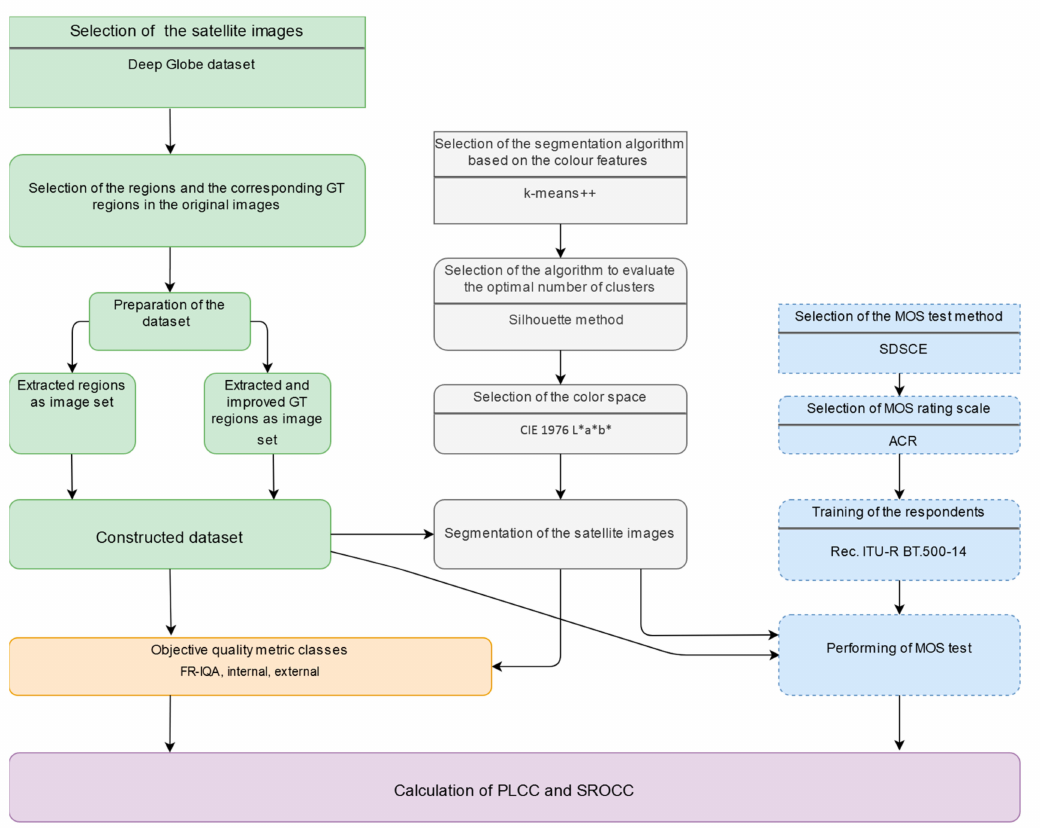
Figure 5. Framework illustrating the workflow for obtaining final results (di ff erent colours present di ff erent branches of the workflow, including the appropriate